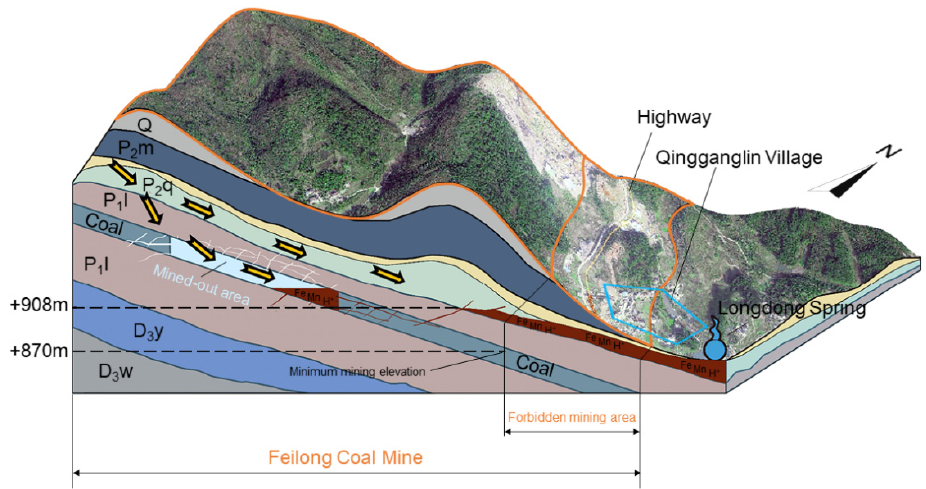
Figure 9. Mine water flows from the coal mine into the Longdong Spring.